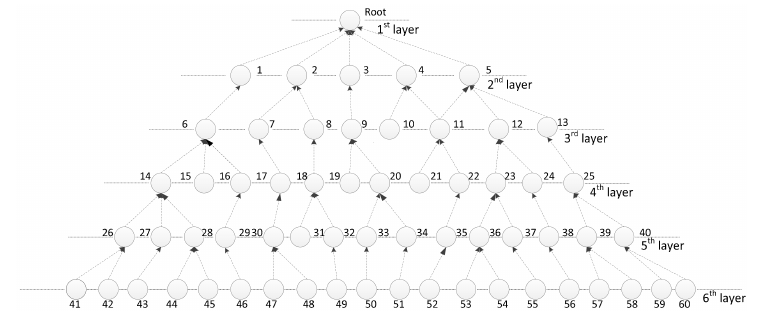
Figure 1. Instance of the system model.